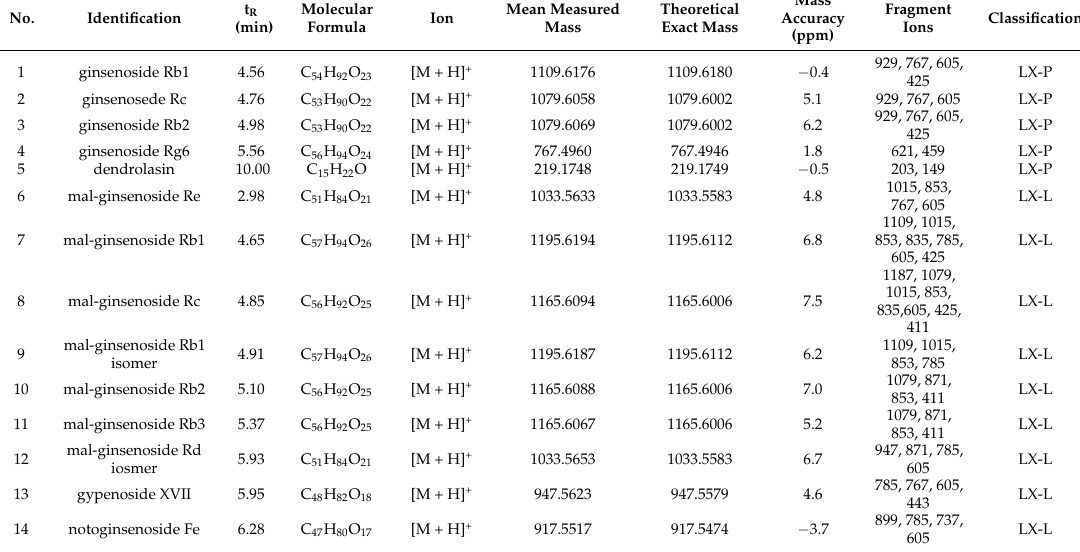
Table 2. Identified maker ions of mountain cultivated ginseng (MCG) in different drying